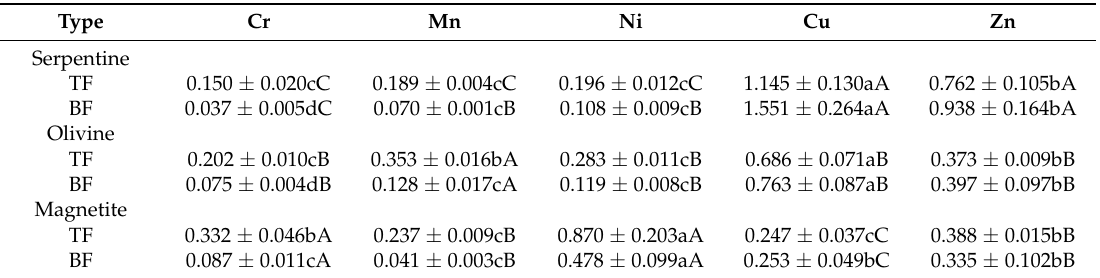
Table 3. Bioaccumulation and translocation factors of heavy metals in Imperata Cylindrica grown in three-type tailing soils.